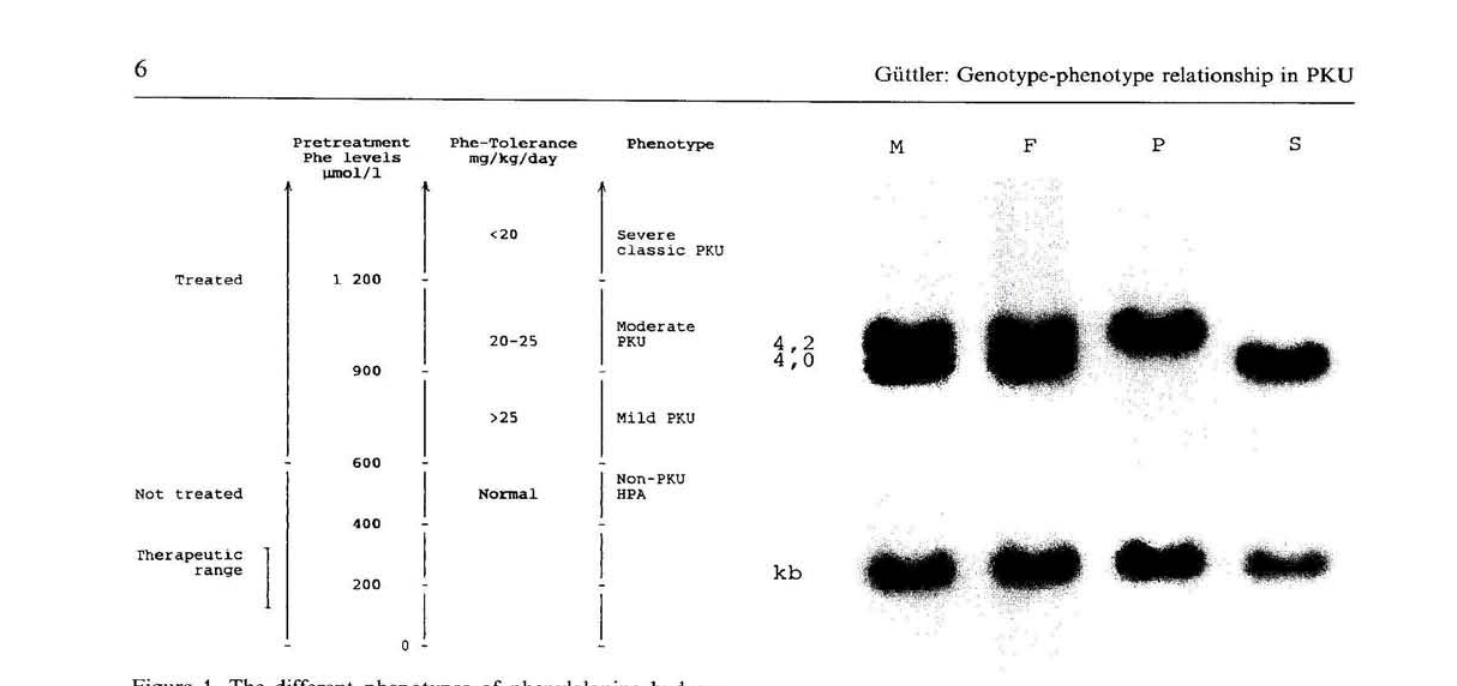
Figure 1. The different phenotypes of phenylalanine hydrox- ylase deficiency classified according to pretreatment phenylal- anine levels and the amount of phenylalanine tolerated in mg per kg body weight per day at 5 years of age. Most centers start treatment, when phenylalanine levels exceed 600 μπιοΐ/ΐ and patients with these levels are classified as having one of the various phenotypes of phenylketonuria (PKU). Individuals with phenylalanine levels below 600 μηιοΐ/ΐ show a normal development without treatment and have the non-PKU hyper- phenylalaninemia (ΗΡΑ) phenotype. Table 1. Relation between the parental phenotype and the combined phenotype of their affected offspring.